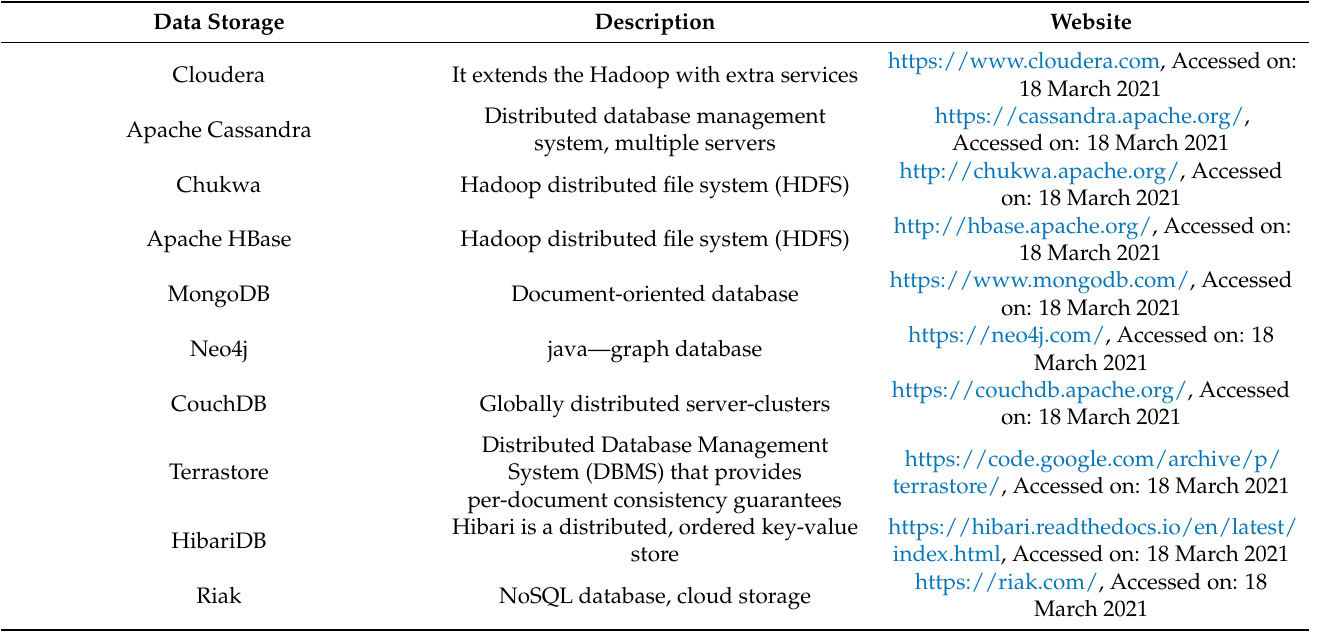
Table 4. Data storage and